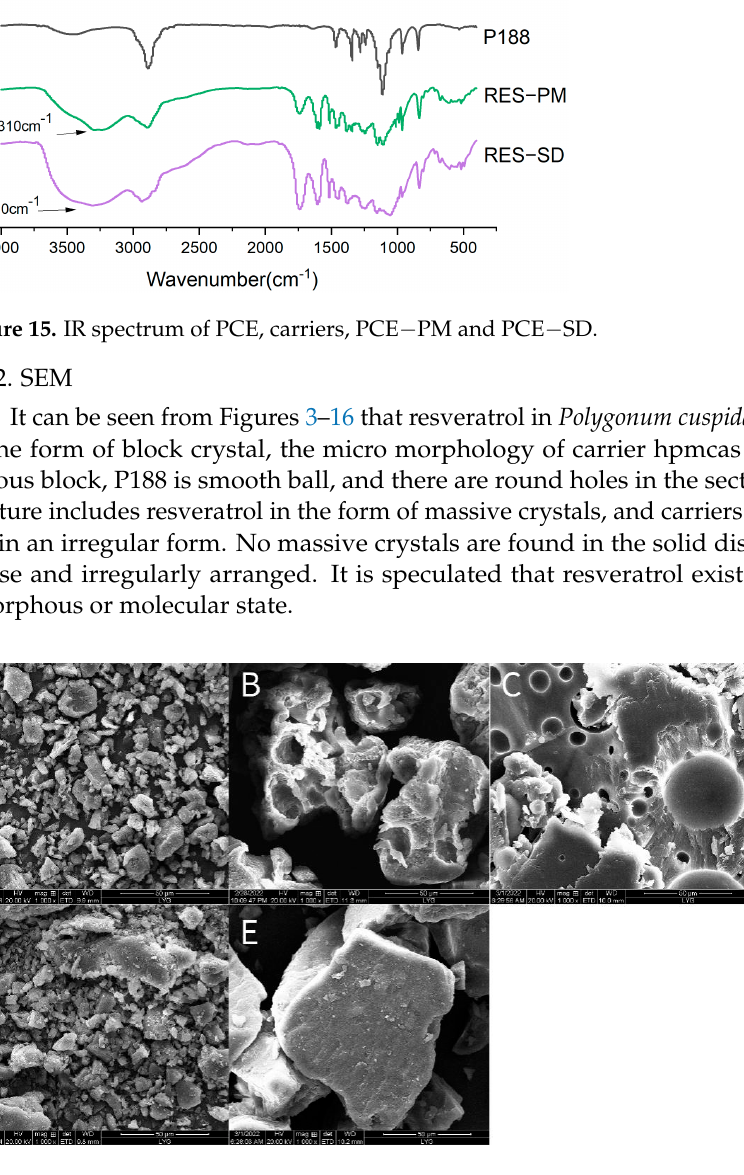
9 of 19 Figure 14. Dissolution curves of three batches of PCE solid dispersions. 2.6. Characterization of the PCE-SD 2.6.1. FTIR Assay The spectra were subtracted from the water vapor spectra. It can be seen from Figure 15 that on the curve of Polygonum cuspidatum extract, there are phenol hydroxyl stretching